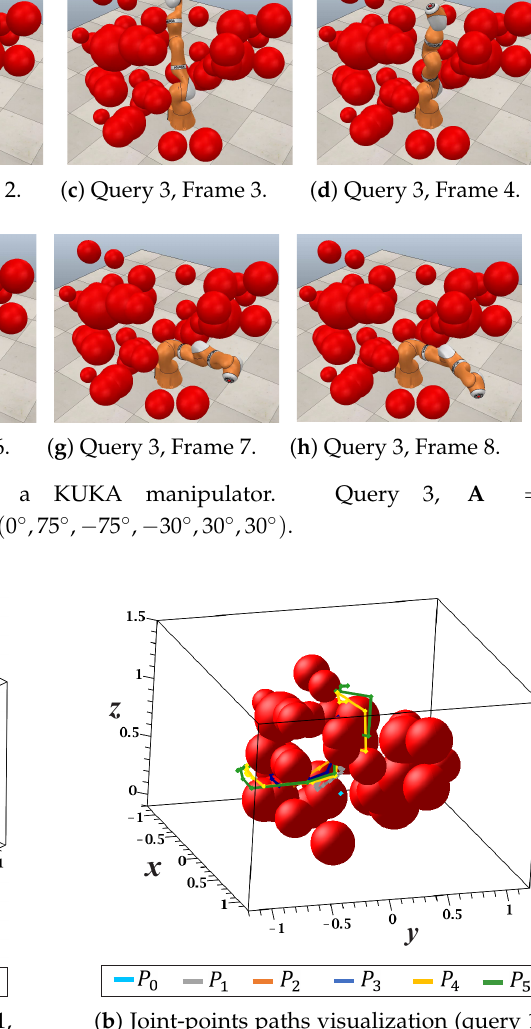
( a ) Joint-points paths visualization (query 1, view 1).